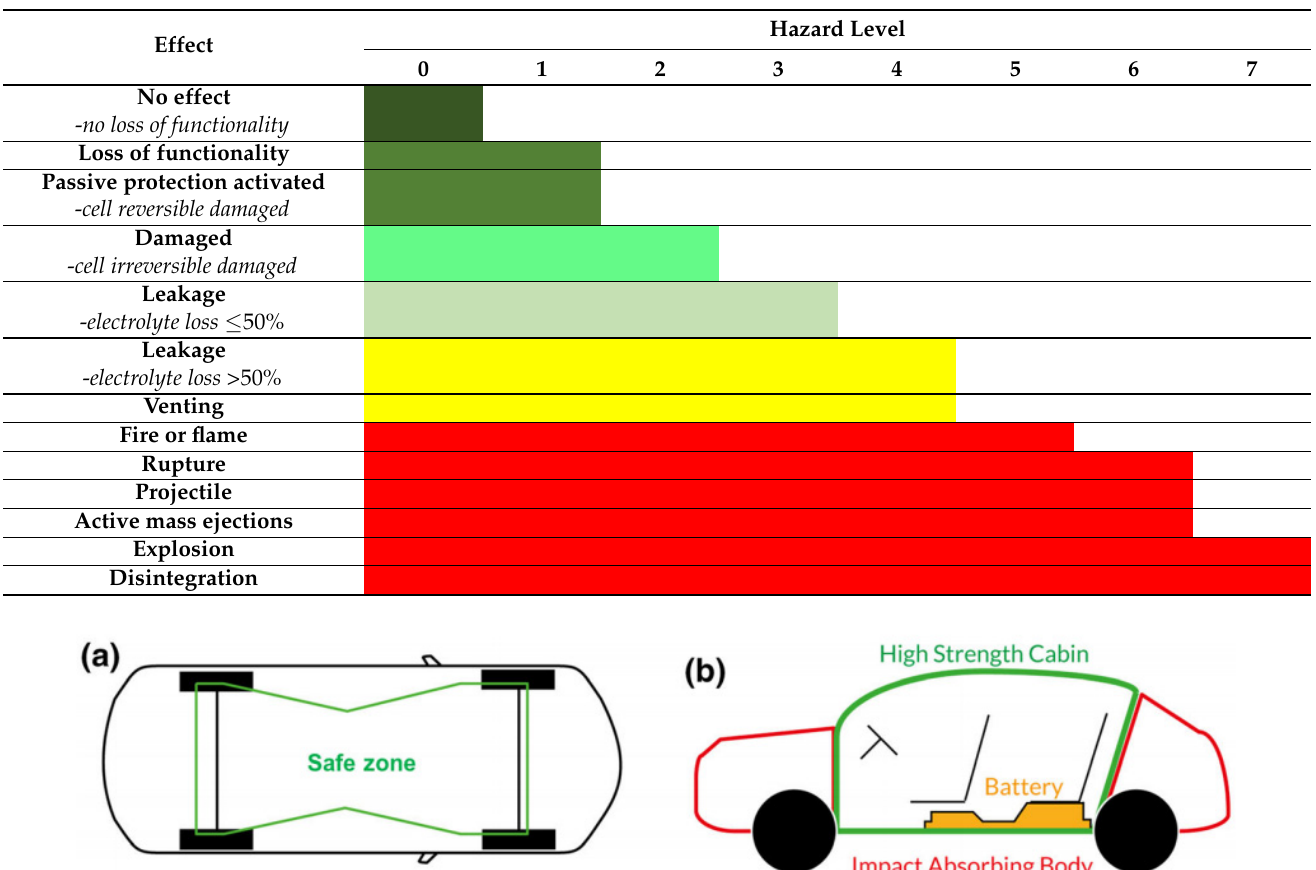
Table 2. EUCAR hazard level for the tested Li-ion battery (from Brandt, Garche [50], with permission from Elsevier).